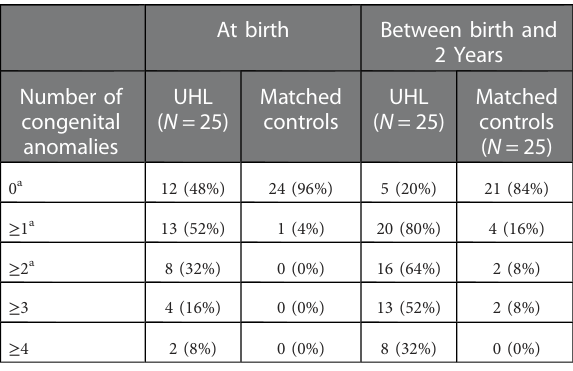
a Indicates there was a statistically signi fi cant difference between the cases (UHL) and matched controls using a chi-squared test ( n >5), or Fischer ’ s Exact where n ≤ 5 ( p